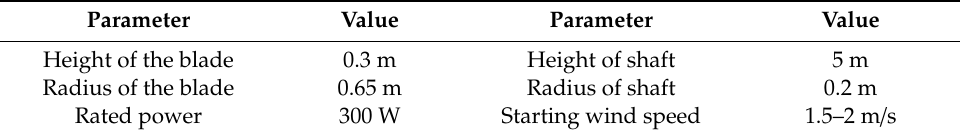
Table 1. The specific parameter of the wind